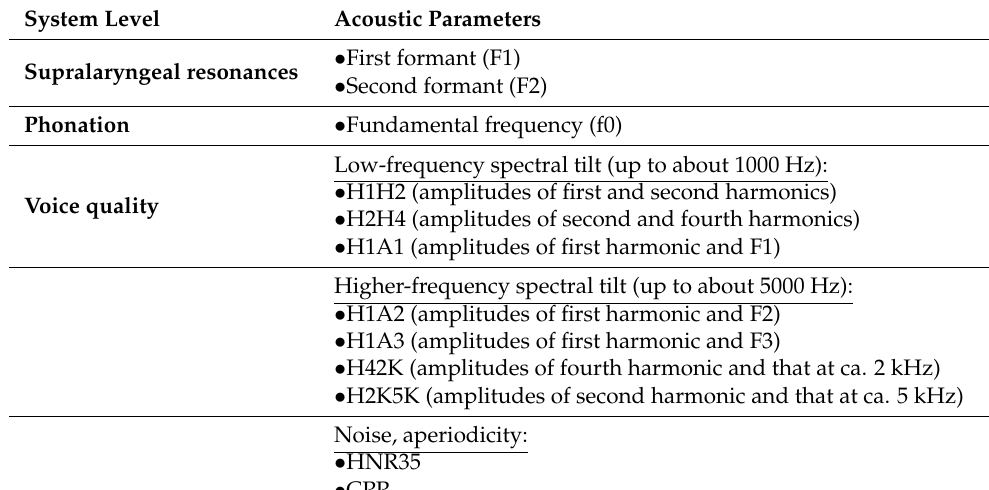
Table 1. Overview of the investigated speech characteristics and associated acoustic parameters. Measures of voice quality are grouped